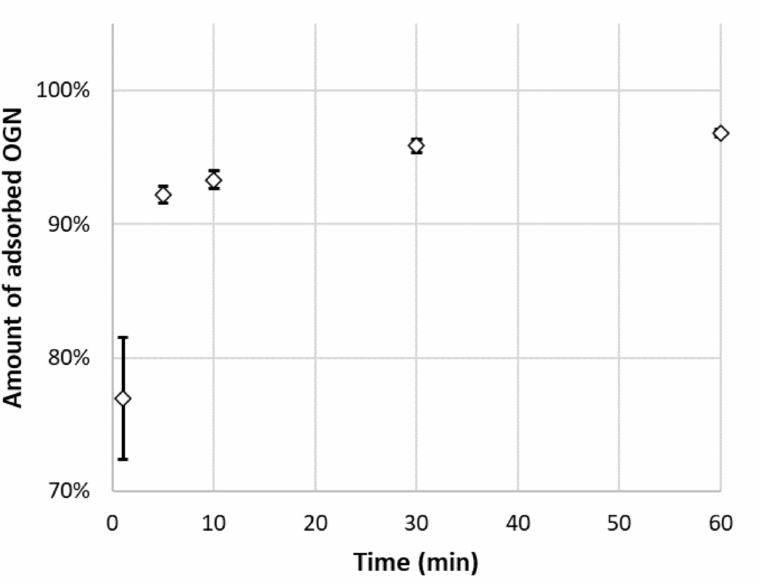
Figure 3. The impact of time on DNA-20 oligonucleotide adsorption effectiveness on MNP-Ac (oligonucleotide sequence is provided in Table 1, MNP-Ac adsorbent structure in Figure 2, and experimental conditions in Section 2.4). Abbreviations: